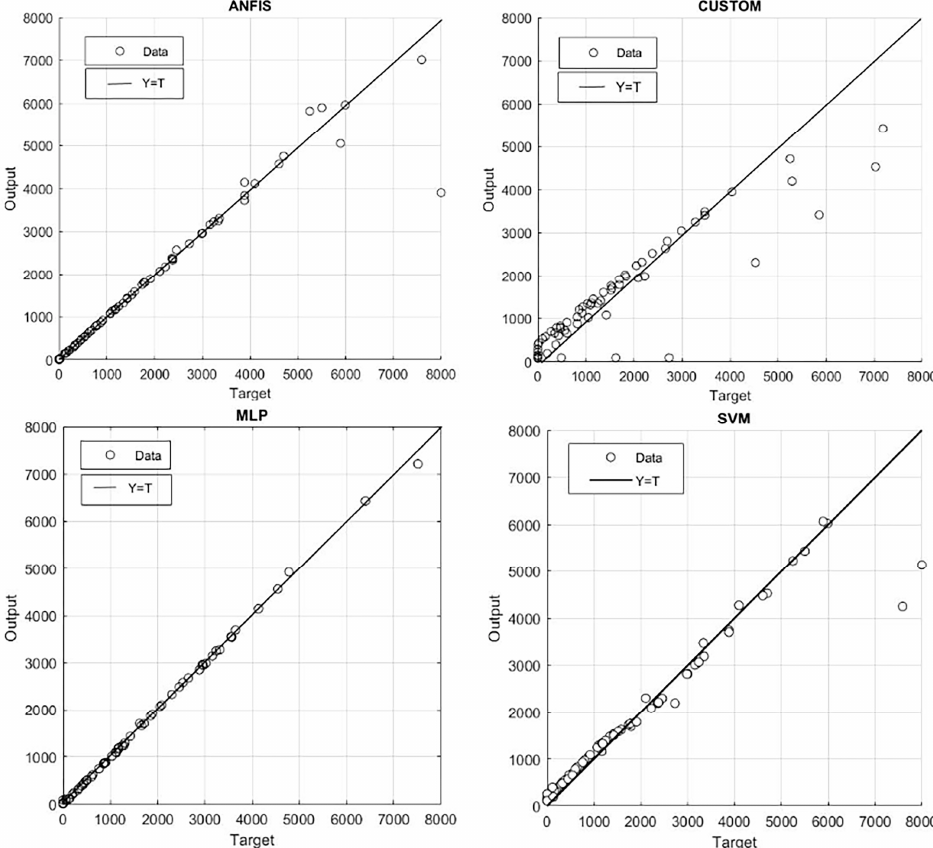
Figure 5. Force simulated (Output) by the ANFIS, custom, MLP, and SVM models in correlation with the force measured by FESTO (Target) for DMSP-40: test